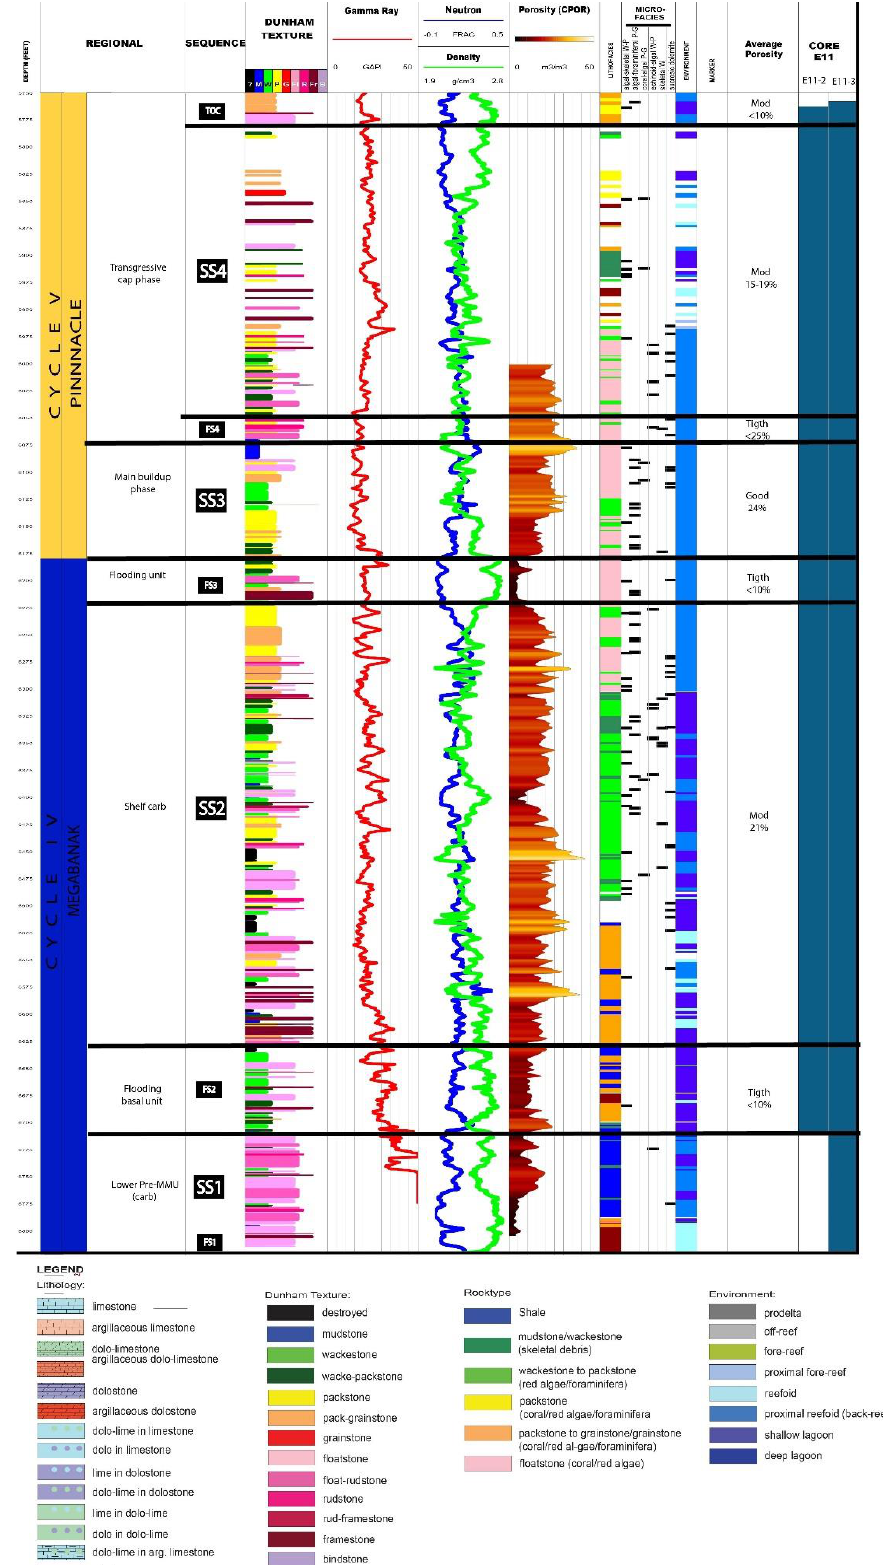
Figure 7. Composite well logs of E11-2. The logs are digitized and visualized using the software Well CAD. Description of the cores includes grain size, lithology, Dunham texture, gamma-ray, neutron, and density, porosity from core plugs, interpreted lithofacies, microfacies, and